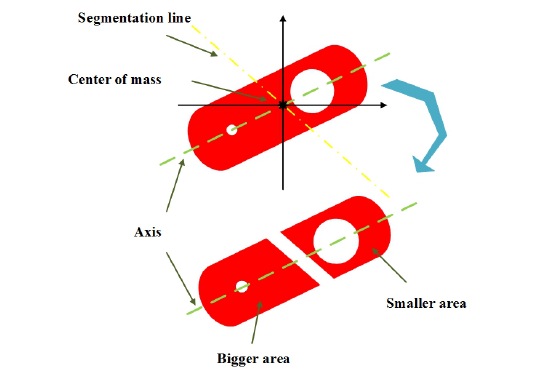
Figure 3. Image segmentation with a separation